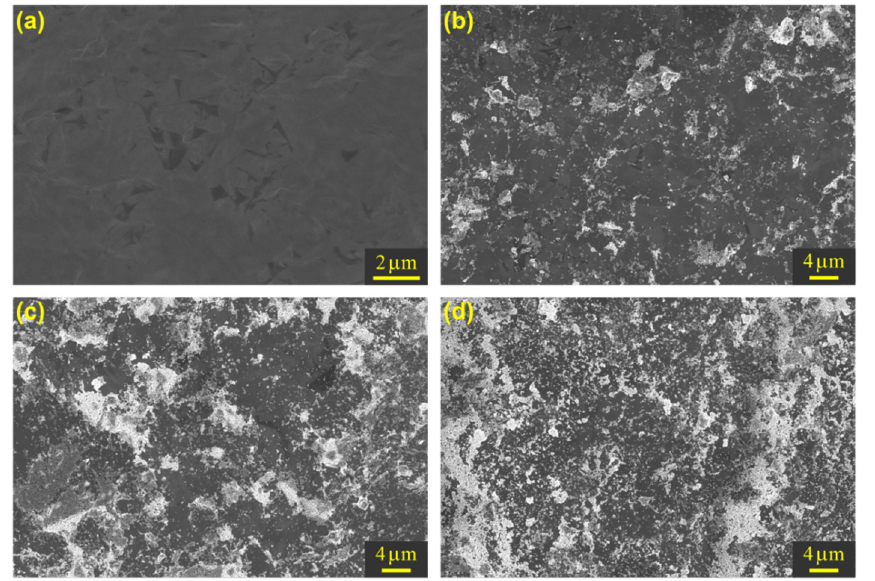
Figure 3. Scanning electron microscopy images of ( a ) rGO and its mixture with ( b ) 5, ( c ) 15, and ( d ) 50 v/v% of In 2 O 3 nanoparticles suspension.